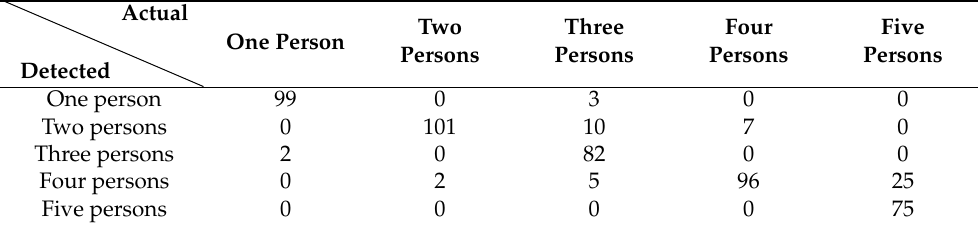
Table 2. The test results for the number of persons in the case of a small office.